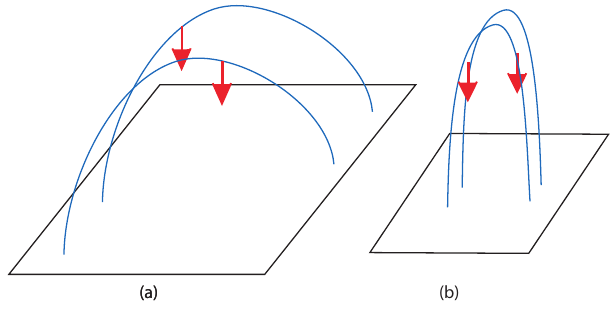
Fig. 8. Sketch of the effect of velocity pulses for (a) large guide field and (b) small or zero guide field. Blue lines are magnetic field lines and red arrows indicate a velocity pulse In case (a) the pulse is primarily Alfv´enic, perpendicular to the magnetic field, while in case (b) the pulse, away from the apex of a loop, is more strongly field-aligned, associated with a compressional wave.